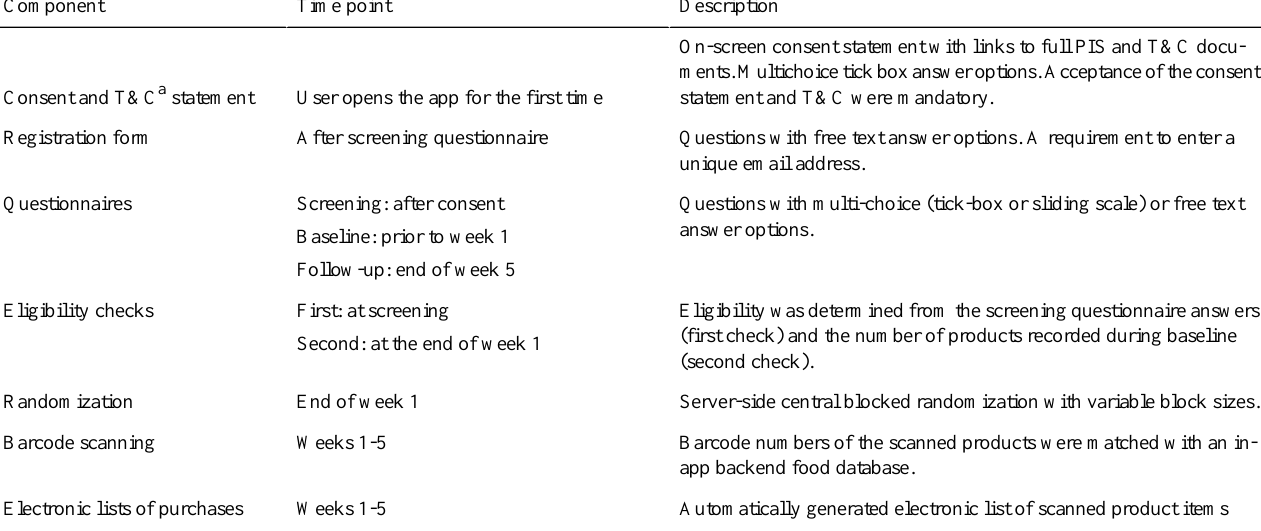
DescriptionTime